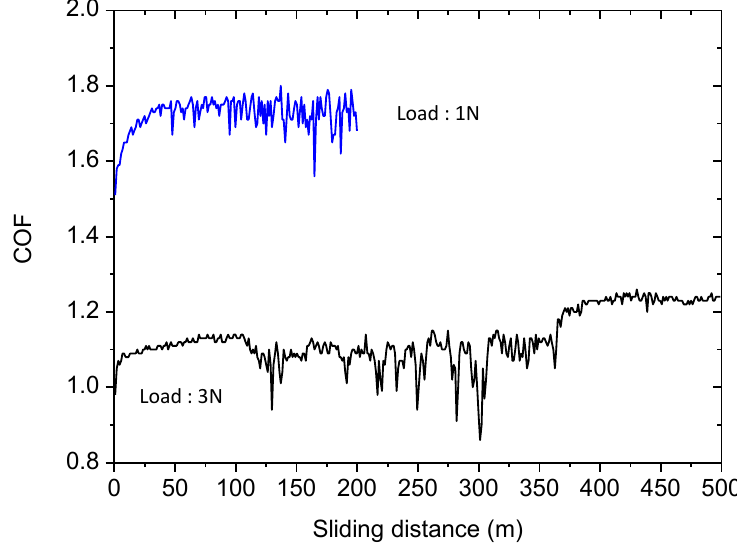
Figure 4. Friction coefficient, COF, recorded during the wear tests against AISI316 ball at 1 and 3 N of normal load with 200 and 500 m of sliding distance,